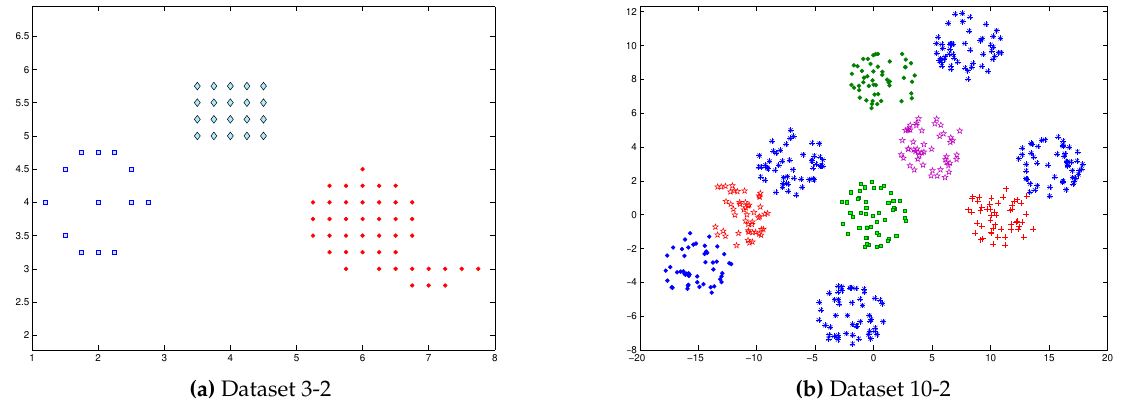
Figure 1. Two synthetic datasets, ( a ) Dataset 3-2 with three clusters and ( b ) Dataset 10-2 with ten